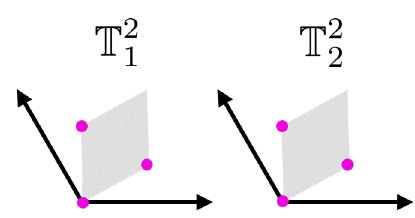
Figure 2 . This depicts the location of the fixed points (pink) of the orbifold ( T 2 × T 2 ) / Z 3 . The lattice Λ = SU(3) × SU(3) is depicted in terms of its generating vectors (black) and the fundamental domain of the orbifold is marked